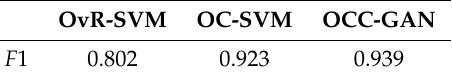
Table 1. The result of F